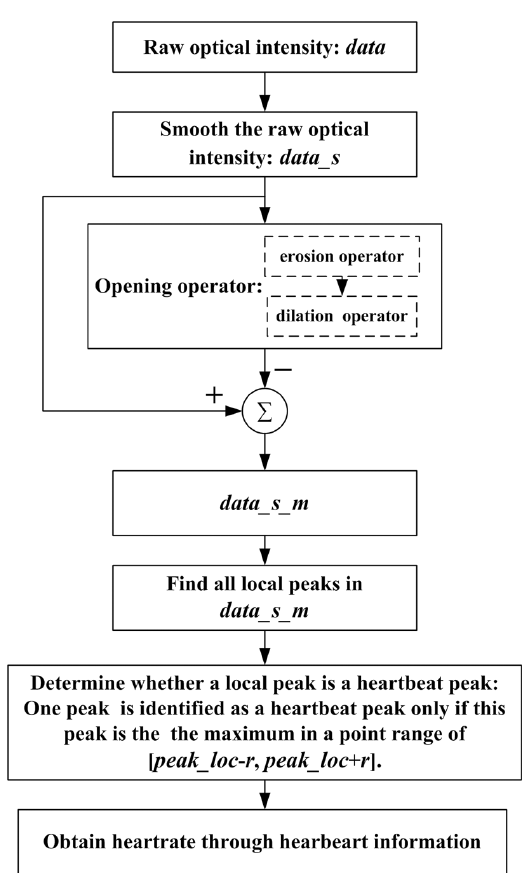
Fig. 1. The schematic diagram of our method for extracting HR in the optical